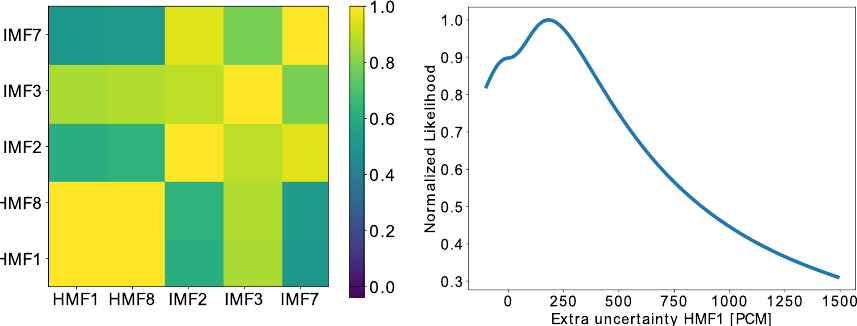
Fig. 2 (Left) The prior calculation correlation between the benchmarks. (Right) The normalized likelihood (y-axis) for the σ extra,b (x-axis) of